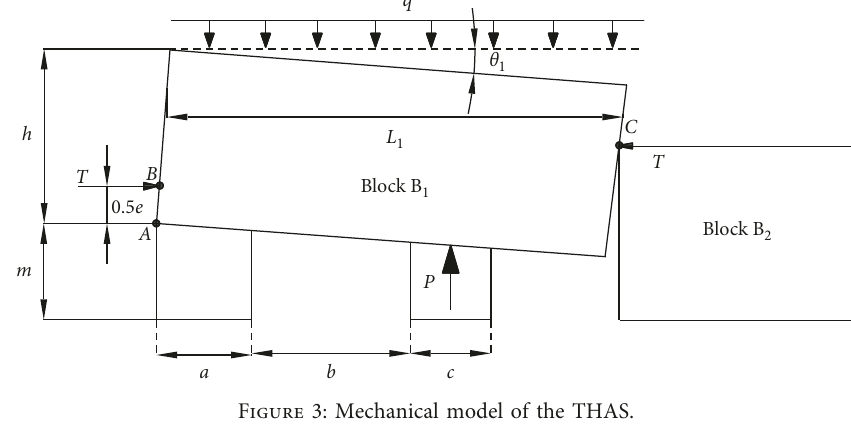
Figure 3: Mechanical model of the THAS.